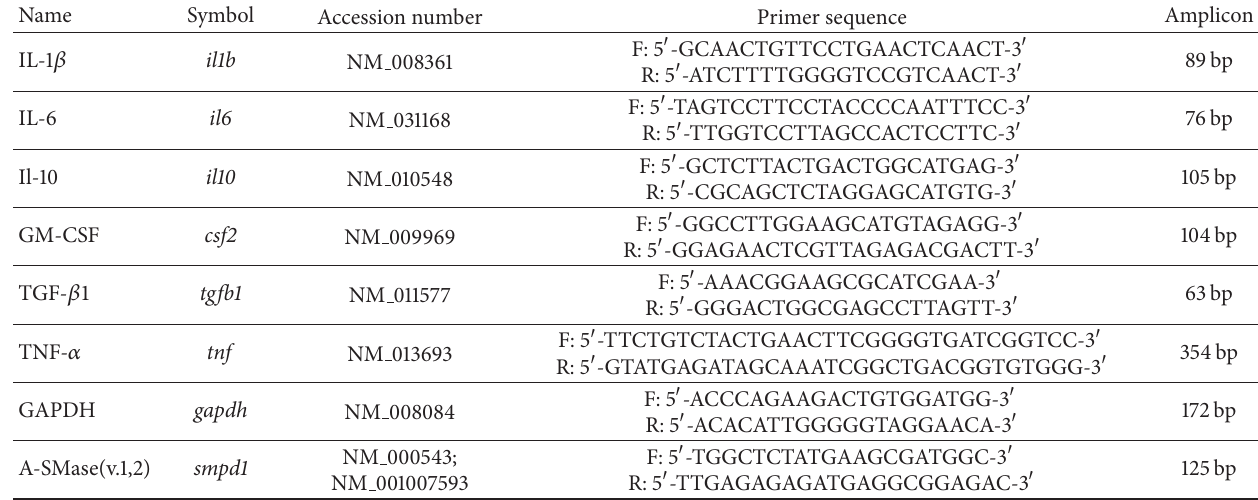
Table 1: Primer pairs designed for PCR analysis.